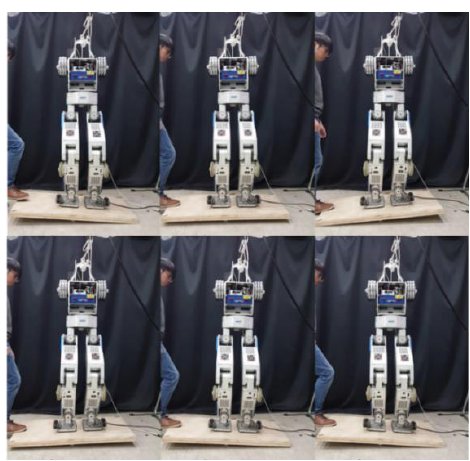
Figure 15. Snapshots of balance control experiment under varying inclination.